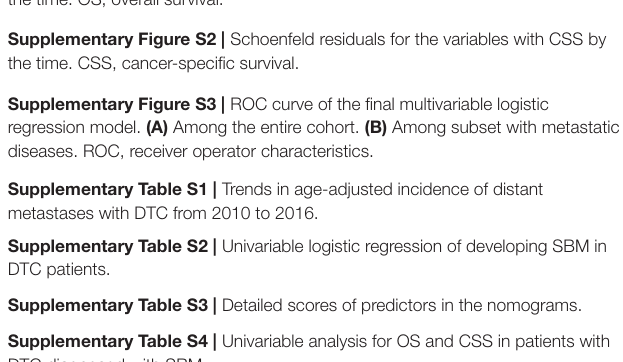
Supplementary Figure S1 | Schoenfeld residuals for the variables with OS by the time. OS, overall survival. Supplementary Figure S2 | Schoenfeld residuals for the variables with CSS by the time. CSS, cancer-specific survival. Supplementary Figure S3 | ROC curve of the final multivariable logistic regression model. (A) Among the entire cohort. (B) Among subset with metastatic diseases. ROC, receiver operator